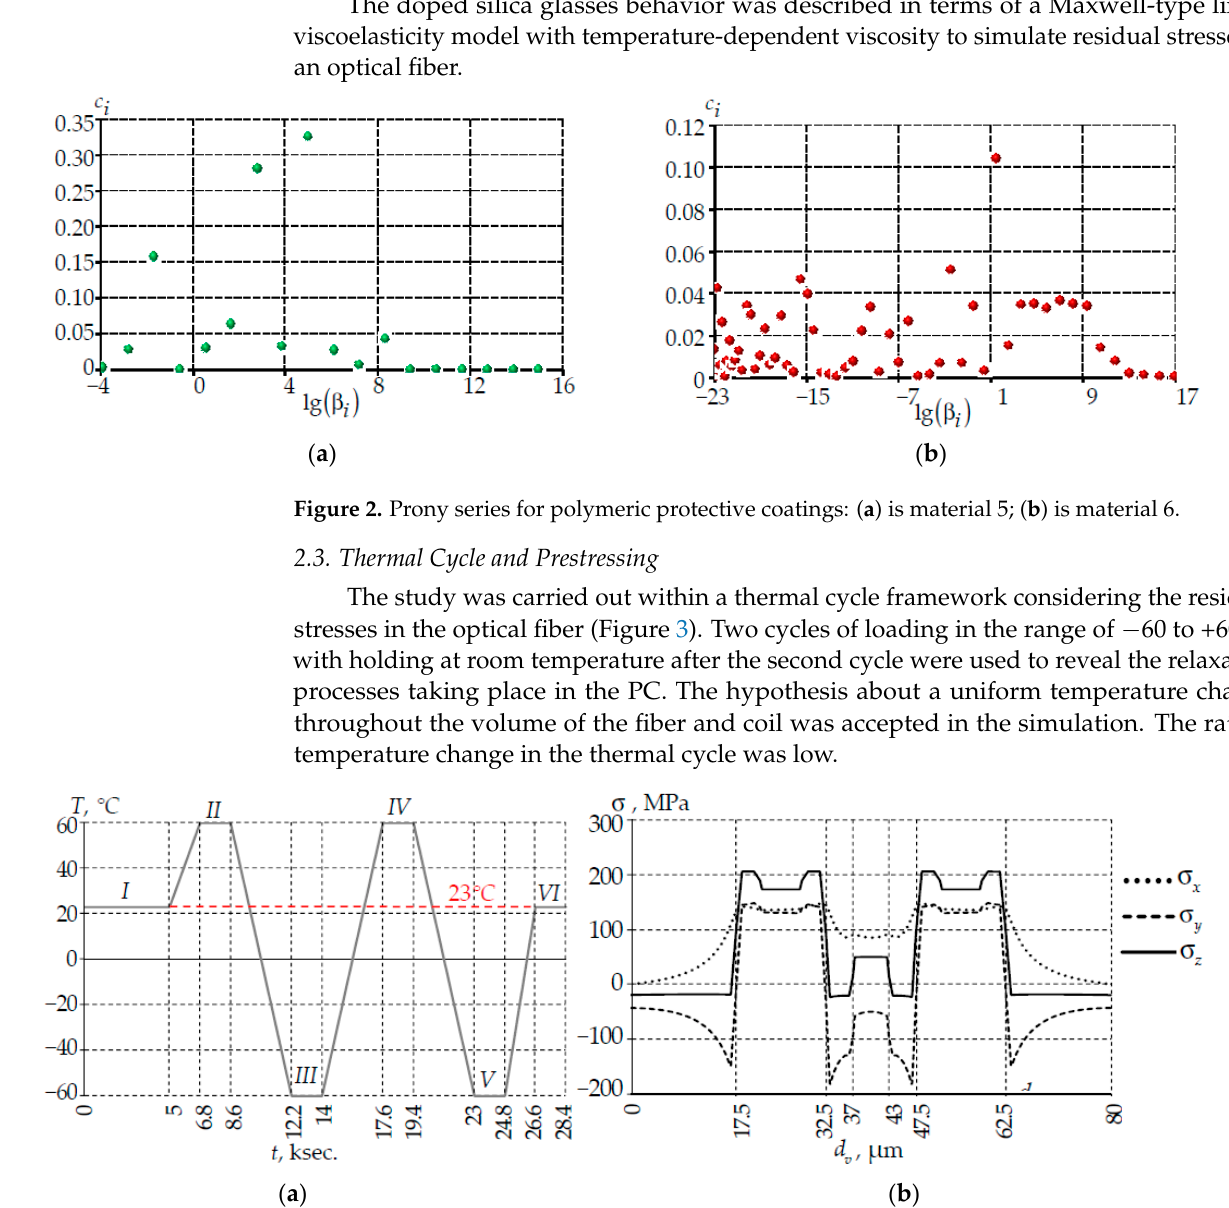
Figure 2. Prony series for polymeric protective coatings: ( a ) is material 5; ( b ) is material 6.